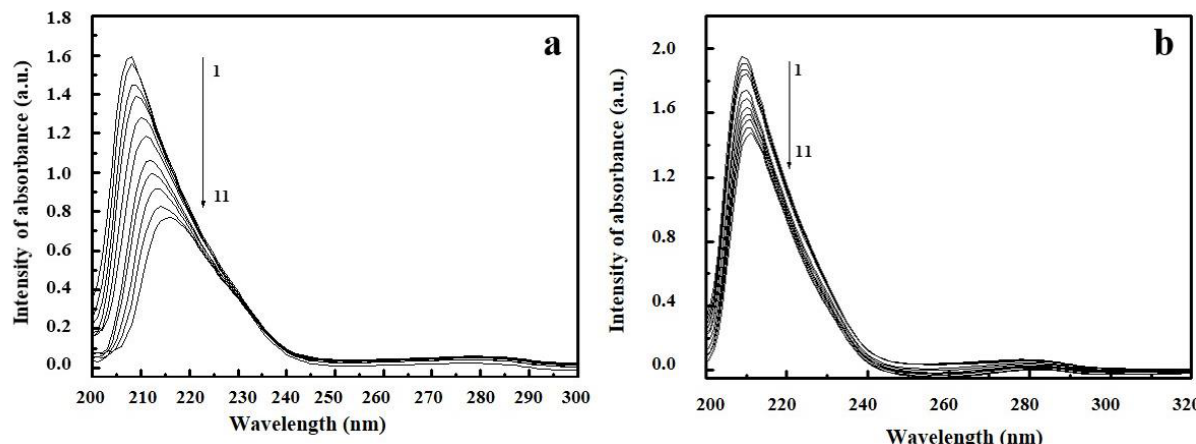
Figure 6. UV/Vis absorption spectra of human serum albumin (HSA) in the presence of epoxiconazole (EPX) ( a ) and prothioconazole (PTC) ( b ). c (HSA) = 2 × 10 −6 mol/L; c (EPX, PTC) = 2 × 10 −6 mol/L–32 × 10 −6 mol/L (1–11).